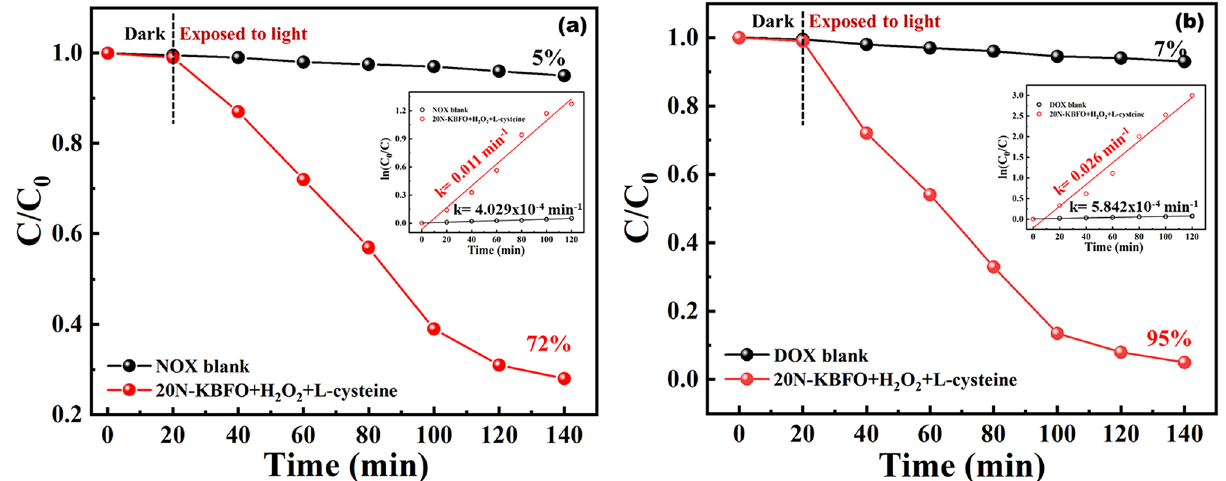
Figure 11. Photocatalytic degradation (C/C 0 ) of ( a ) Norfloxacin (NOX) and ( b )Doxycycline (DOX) by 20N-KBFO + H